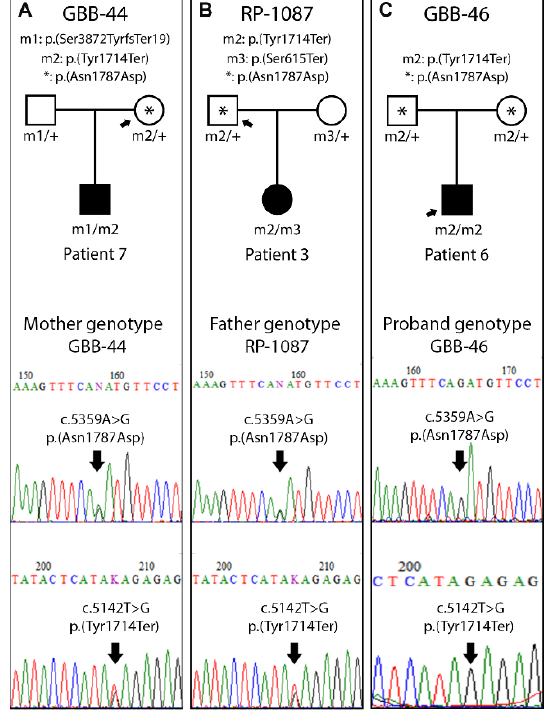
Figure 3. Single nucleotide polymorphism (SNP) segregation study in 3 families. ( A ) The mother ´ s genotype from family GBB-44, carrier of p.(Asn1787Asp) and p.(Tyr1714Ter) in heterozygosis. ( B ) The father ´ s genotype from the RP-1087 family, carrier of p.(Asn1787Asp) and p.(Tyr1714Ter) in heterozygosis. ( C ) The genotype of the GBB-46 proband with p.(Asn1787Asp) and p.(Tyr1714Ter) in homozygosis. *: p.(Asn1787Asp) (c.5359A>G;